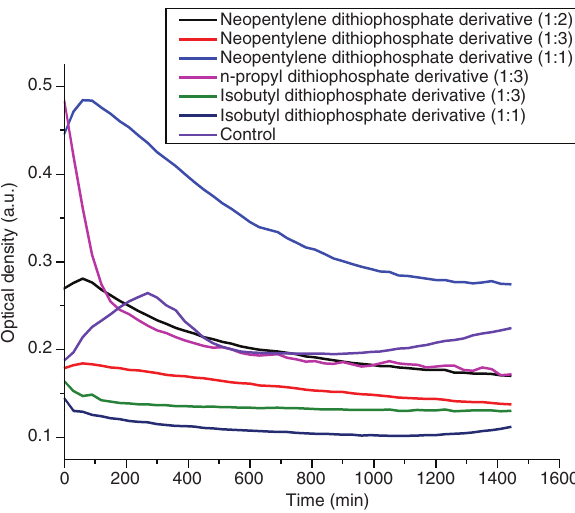
Figure 1: Antimicrobial effect of dithiophosphate derivatives on Escherichia coli.